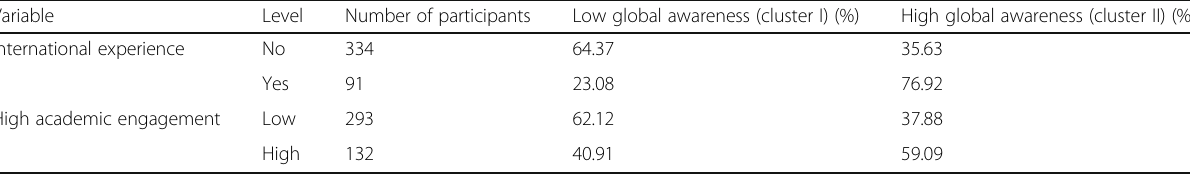
Table 9, 76.92% of the students in this composite cat- egory were in the high global awareness cluster. After international experience, the secondary influen- tial demographical/academic variables were related to academics such as double major (61.9% in cluster II), en- rolled in a minor (59.76% in cluster II), and participating in undergraduate research (65.57% in cluster II). We Table 9 Composite characteristics of students classified as low (cluster I) or high (cluster II) global awareness